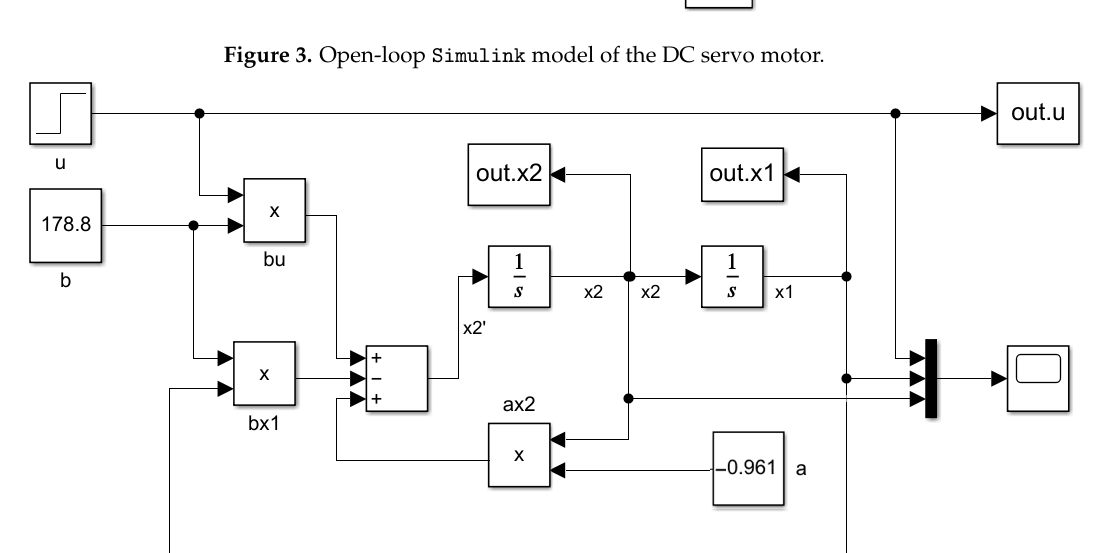
Figure 4. Closed-loop Simulink model for position tracking of the DC servo